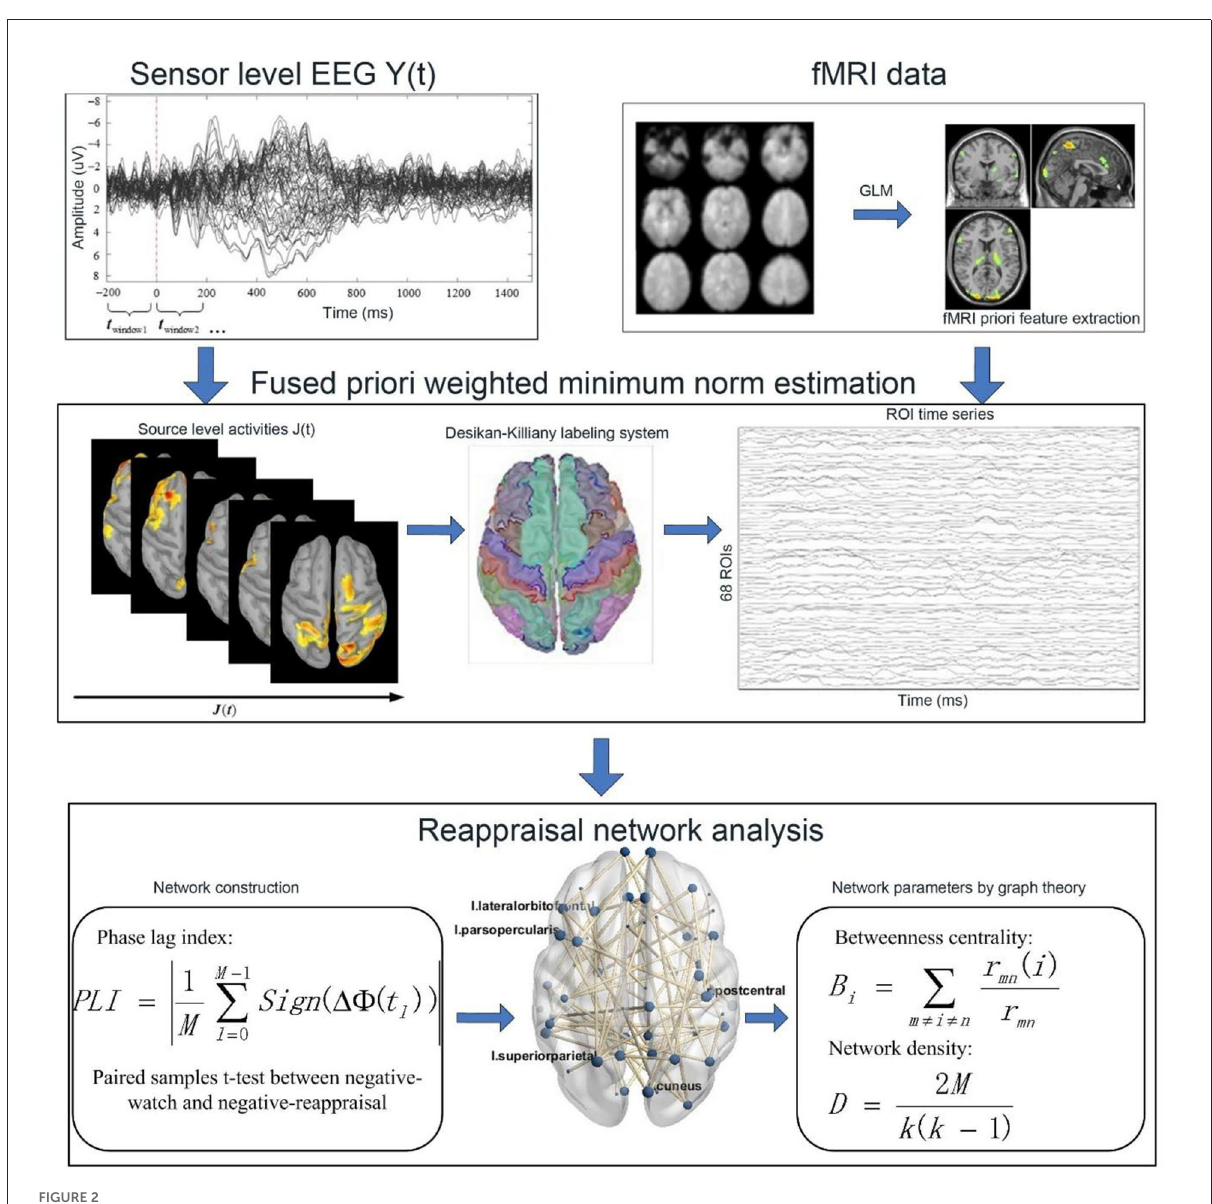
FIGURE2 Flowchart of the analytical